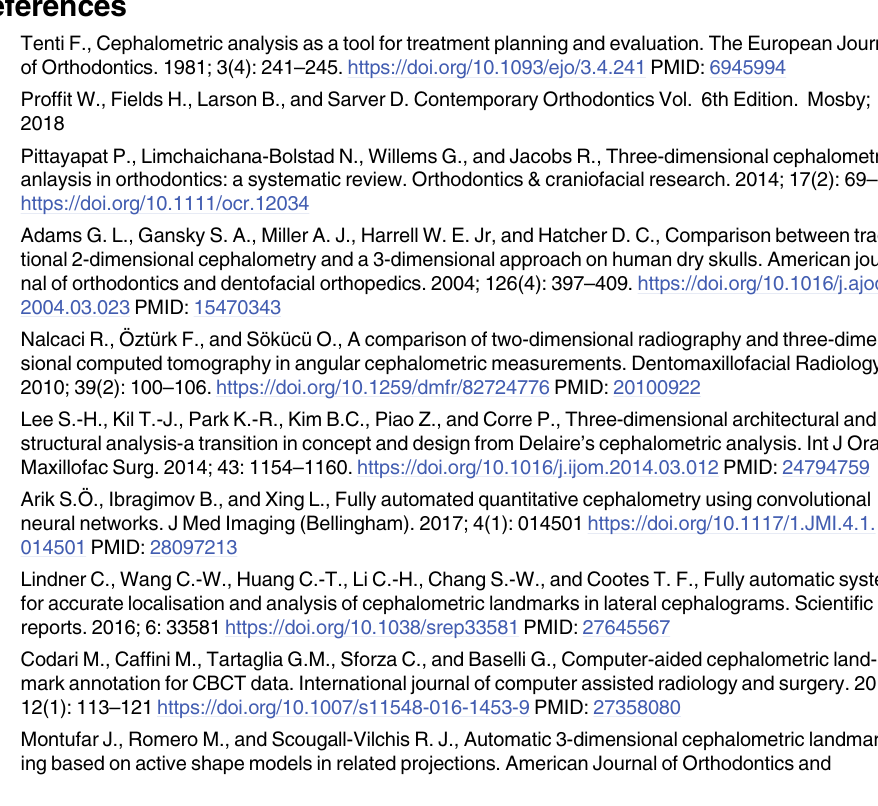
S1 Table. About 90 cephalometric